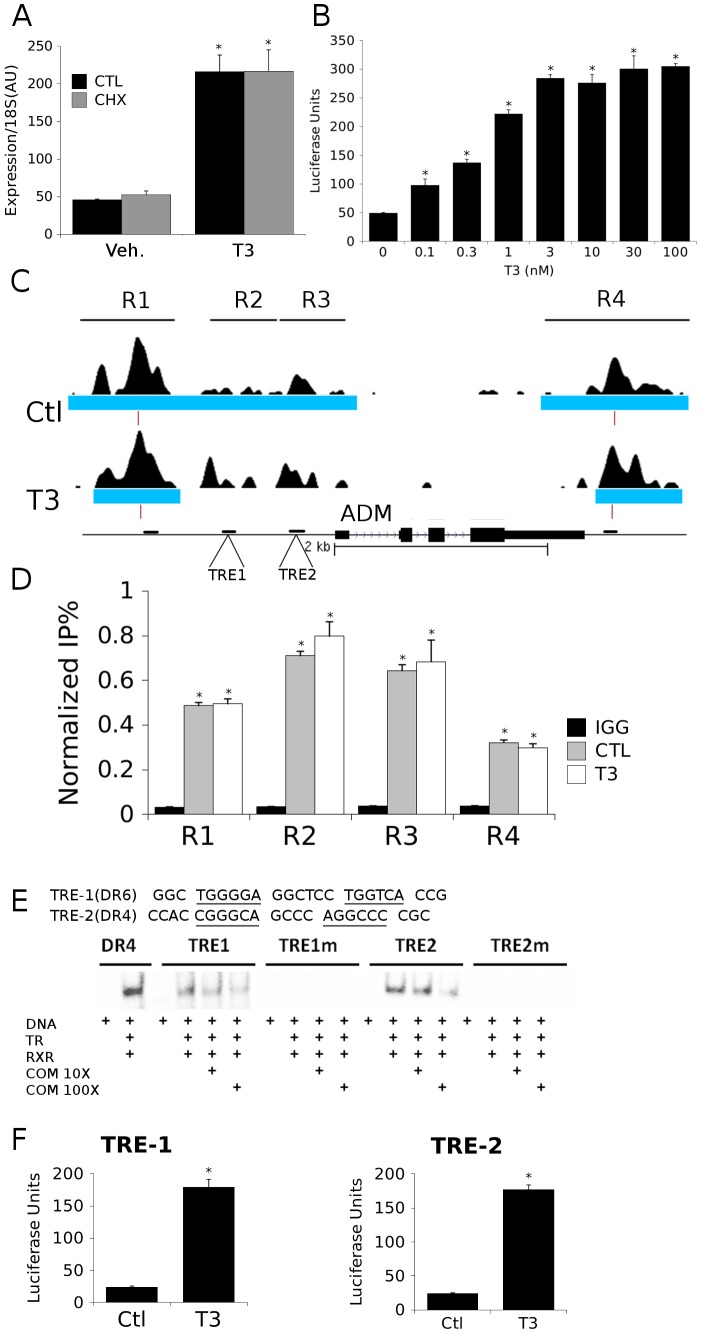
Links between TR Binding and Adm Transcription.A. Graph showing results of realtime PCR analysis of adm transcription in the B7B cells after six hours of T3 treatment +/−10 µg/ml CHX cotreatment of B7B cells. B. Patterns of TRβ binding peaks at the adm locus (UCSC Genome Browser), in similar format to Fig. 4. TRβ binding events clustered into four regions (R1, R2, R3, R4), upstream and downstream of this transcript, as well as a substantial amount of binding immediately proximal to the transcriptional start site. C. Binding of TRβ was confirmed by realtime ChIP PCR analysis in B7B cells at the regions indicated (ChIP primers are depicted by horizontal bars in B). D. The proximal promoter region of adm (corresponding to R2) conferred T3-dependent increases in luciferase activity upon a standard reporter after transfection into B7B. E. Results of gel shift confirming direct TRβ binding to two putative response elements, designated TRE-1 and TRE-2 that were found in R2 at positions marked in Fig. 6B. Individual lanes show shifts obtained with elements and RXRα-TRβ +/− competitor DNA or mutated versions of both elements. F. Luciferase reporter assays confirming that TRE-1 and TRE-2 confer T3 responsiveness on a reporter gene. (*P<0.05 by Student's T-Test).